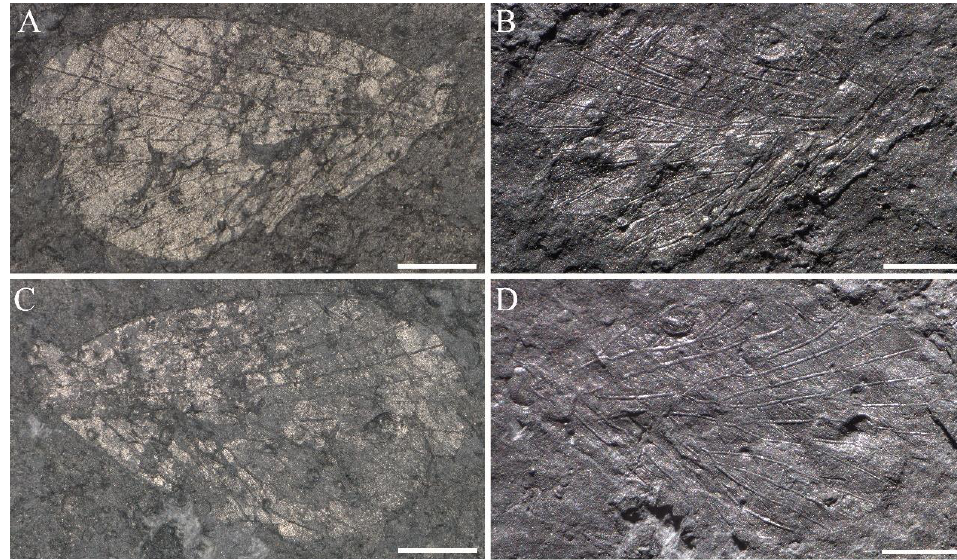
Figure 16. Permoagetopanorpa incompleta sp. nov., NIGP200929 (holotype). ( A , B ) Photographs of part; ( C , D ) Photographs of counterpart; ( A , C ) were taken when specimens were immersed under 70% alcohol in vertical reflected light; ( B , D ) were taken in oblique reflected light. Scale bars represent 1 mm in ( A – D ).